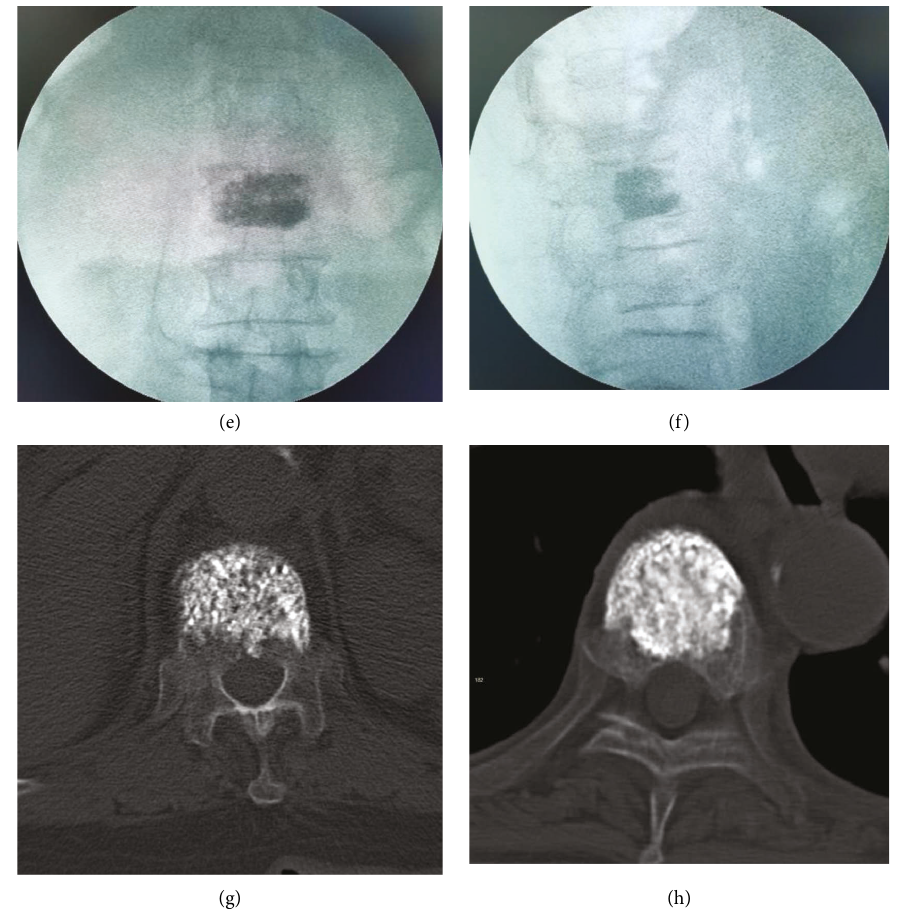
Figure 1: Intraoperative and postoperative CT images of unilateral arcuate vertebroplasty. (a, b) show the front and side views after successful puncture of the arcuate puncture cannula; (c, d) show the front and side views of the arcuate guide needle placed in the vertebral body; (e, f) show the front and side views after bone cement injection; (g, h) show the CT images after bone cement